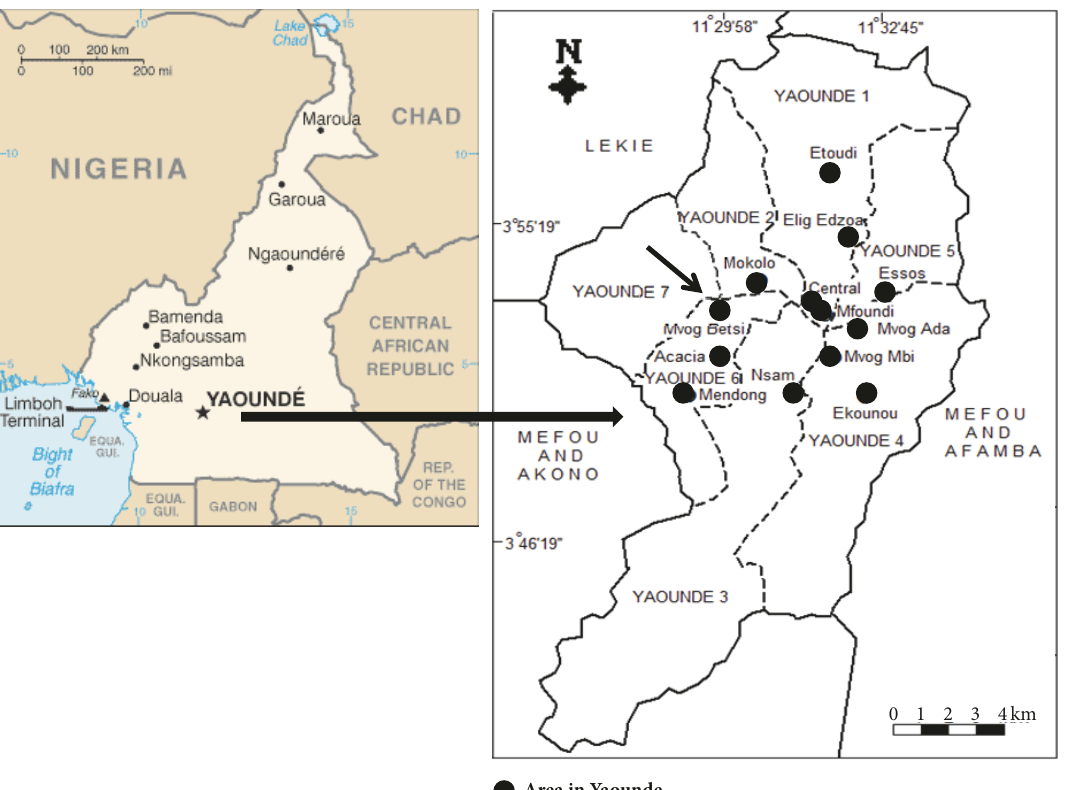
Figure 2: Map of Yaounde showing Mvog-Betsi area (arrow) where the first highly pathogenic avian influenza outbreak took place in May